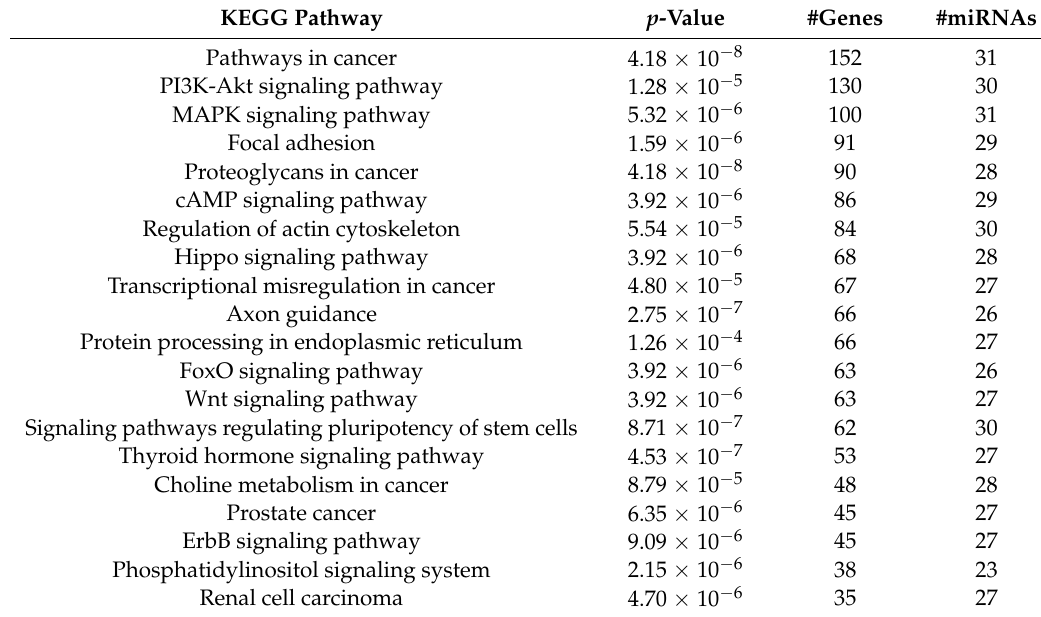
Table 4. Top 20 KEGG pathways from enrichment analysis of up-regulated miRNAs in SHH MB CSC. The entire table is reported in Table S5.